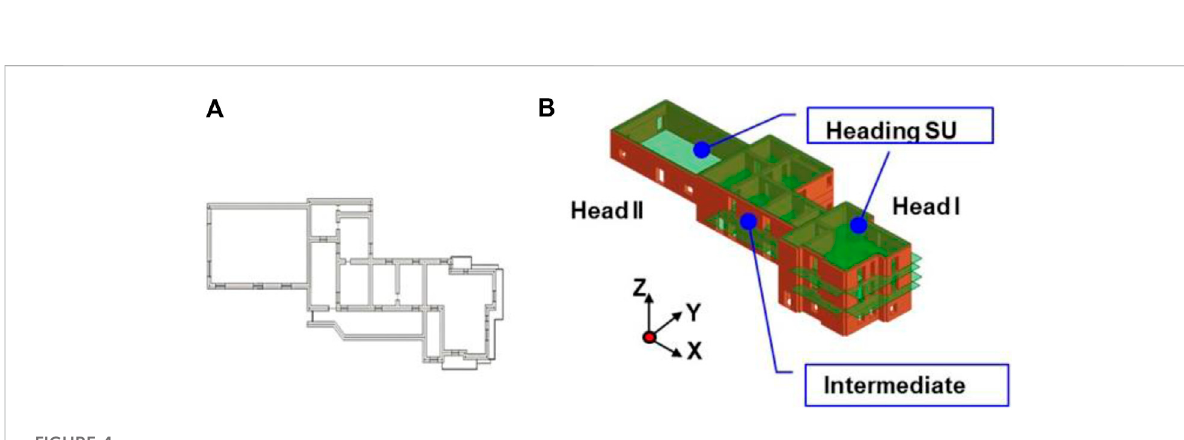
Intermediate, and Head II) were derived by considering as base shear the sum of shears of masonry piers belonging to each structural units, so considering the in fl uence of adjacent walls, and as top displacement the average values of displacement values of the roof nodes of that SU. In particular, for walls in